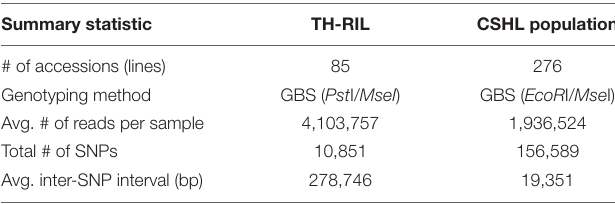
TABLE 1 | Number of sequencing reads generated from GBS and SNPs from GWAS and QTL mapping. Summary